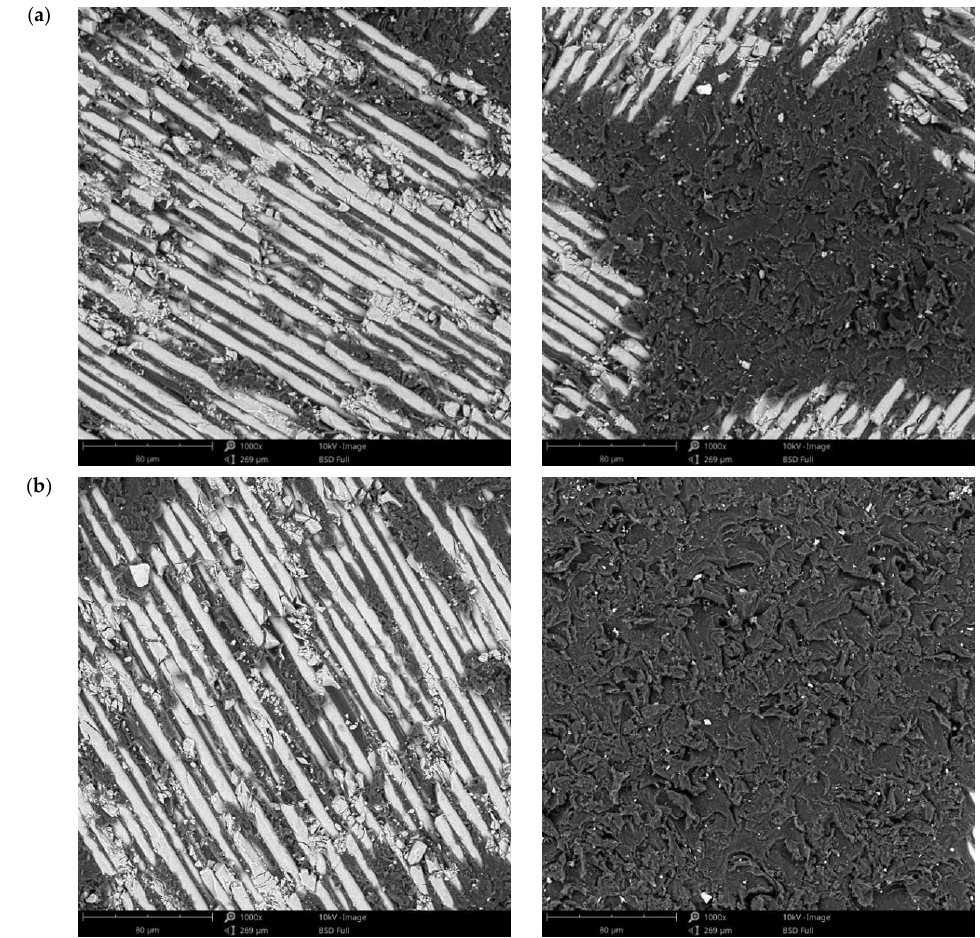
Figure 7. SEM images of the C1 sample surface after immersion tests at ( a ) 3 days and ( b ) 21 days in artificial saliva with pH 7.6 (1000×).